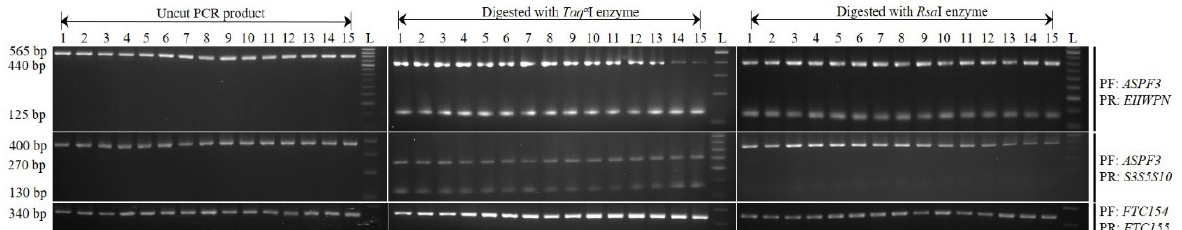
Figure 5: A set of productive apple trees currently growing in Michigan, USA during summertime are shown for comparison purpose. A-C: Three different trees; D-I: Fruit bearing branches. The scale bars for trees and fruit bearing branches represent 1 m and 1 cm respectively.